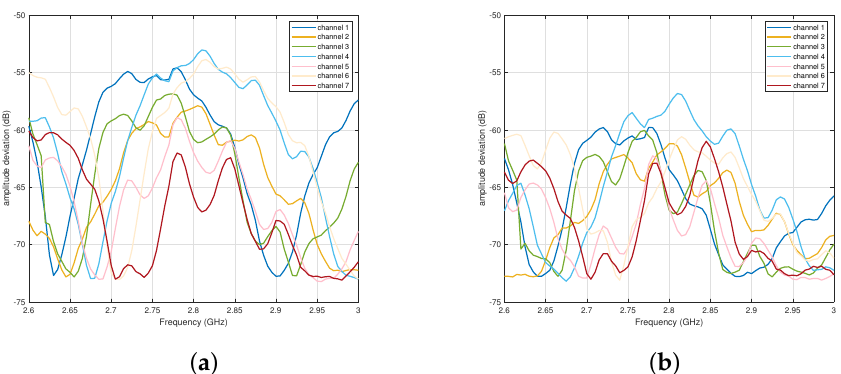
Figure 6. Amplitude deviations of each channel. The maximum amplitude deviations are reduced from about − 53 dB to less than − 55 dB. ( a ) Amplitude deviations before calibration; ( b ) Amplitude deviations after calibration.